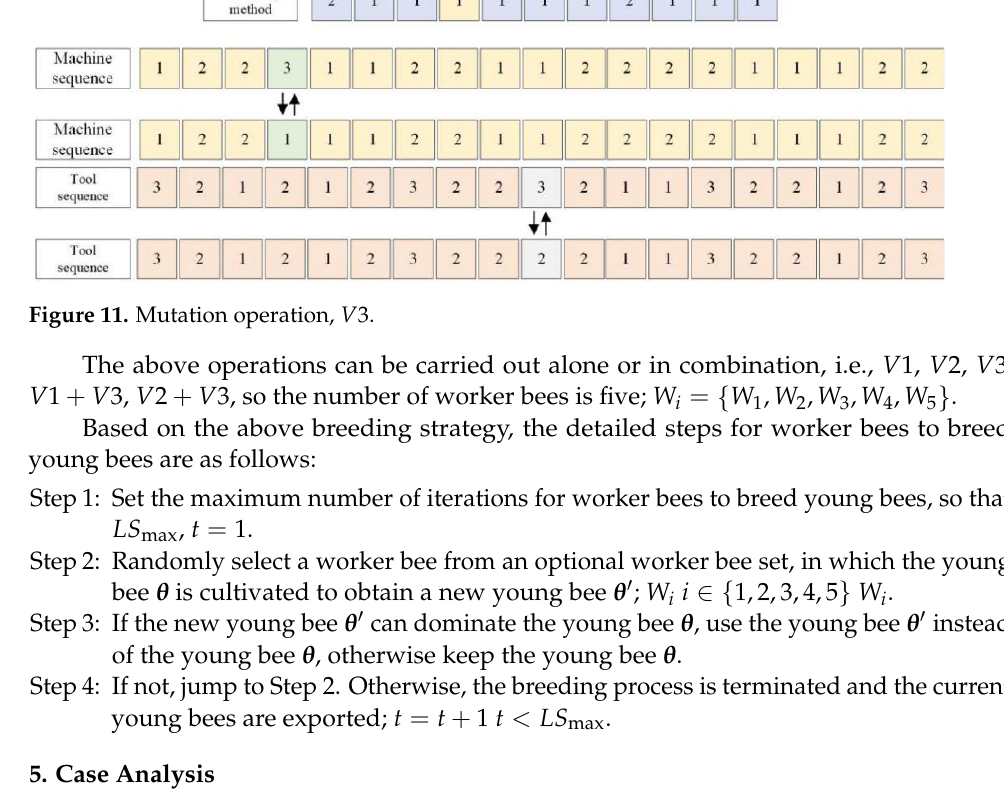
Figure 10. Insert Operation, 2 V .